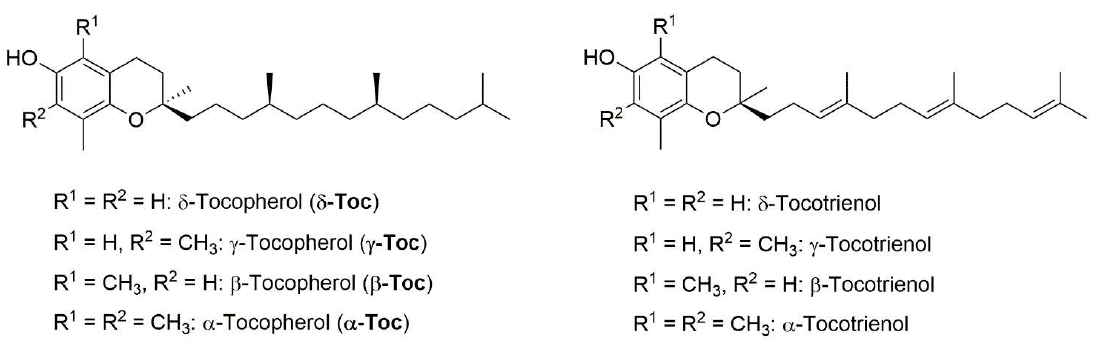
Figure 1. Structure of α -, β -, γ -, and δ -tocopherol ( α - , β - , γ -, and δ -Toc ), and the corresponding α -, β -, γ -, and δ -tocotrienol.